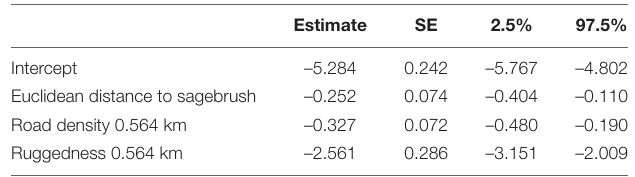
TABLE 3 | Standardized coefficient estimates and profile likelihood 95% confidence intervals for top spring/summer resource selection function model.